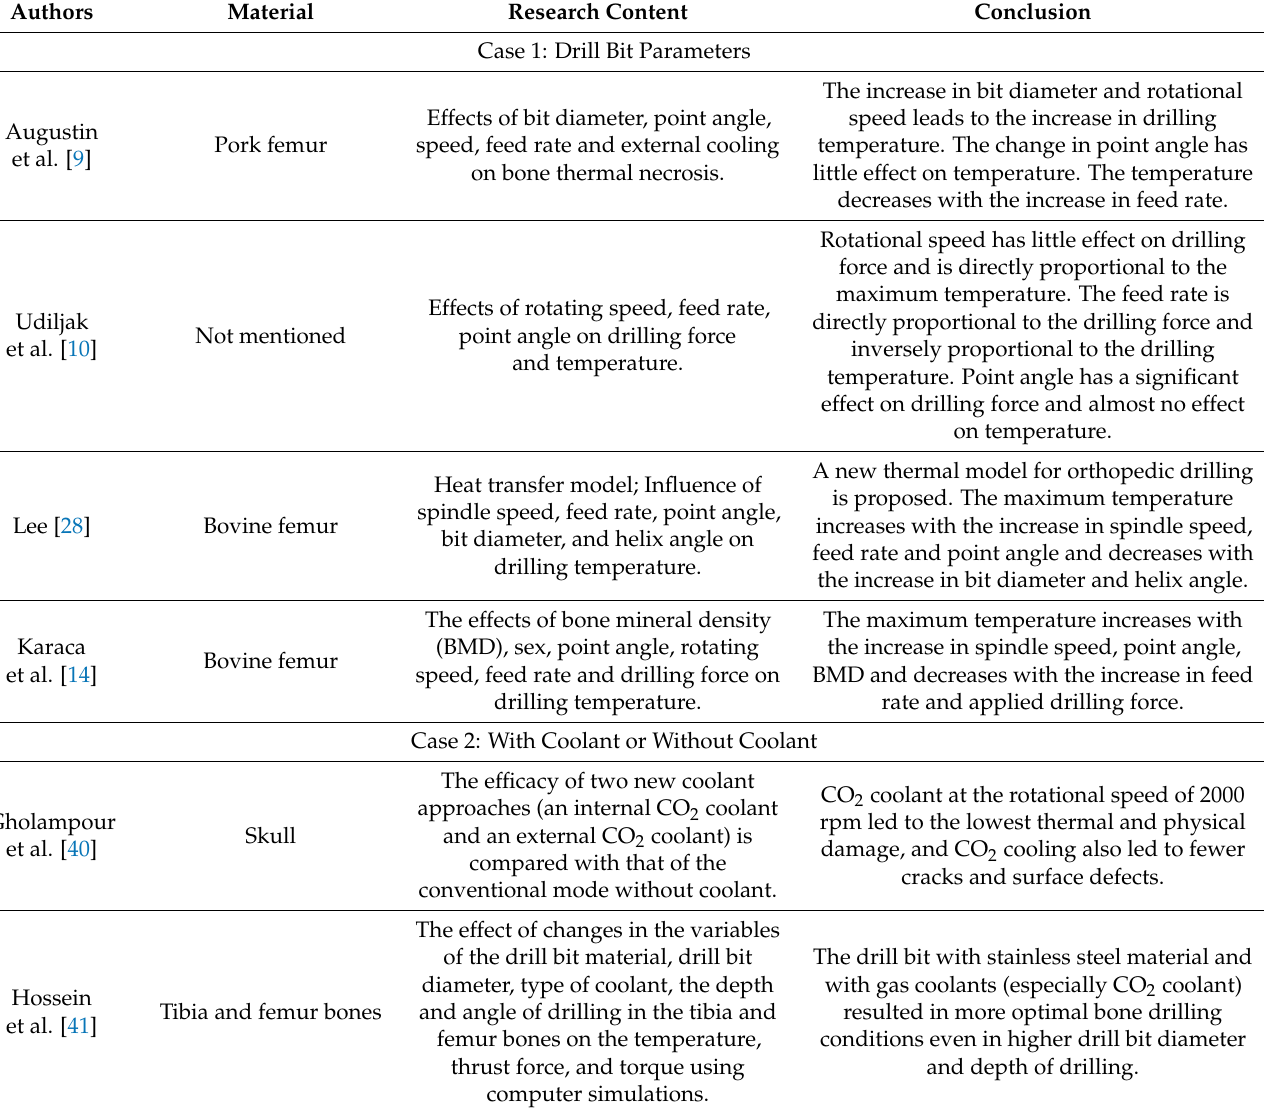
Table 8. Comparison between previous mostly related studies and this